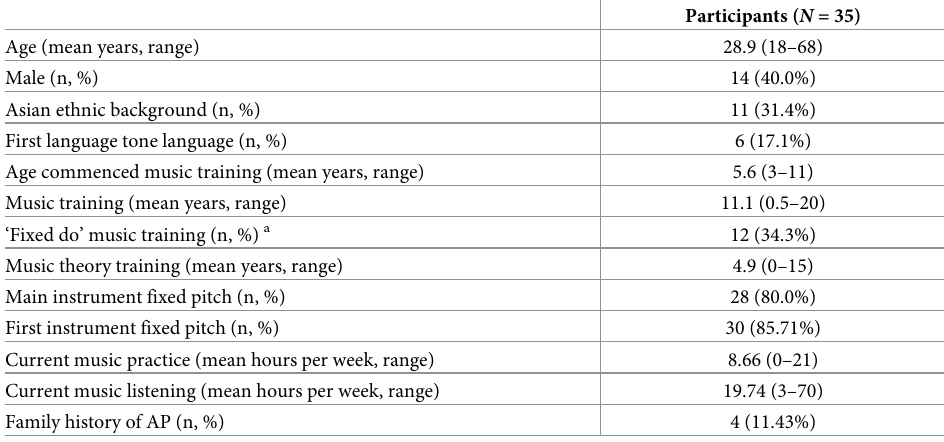
Table 1. Demographic characteristics and music experience of the participants.